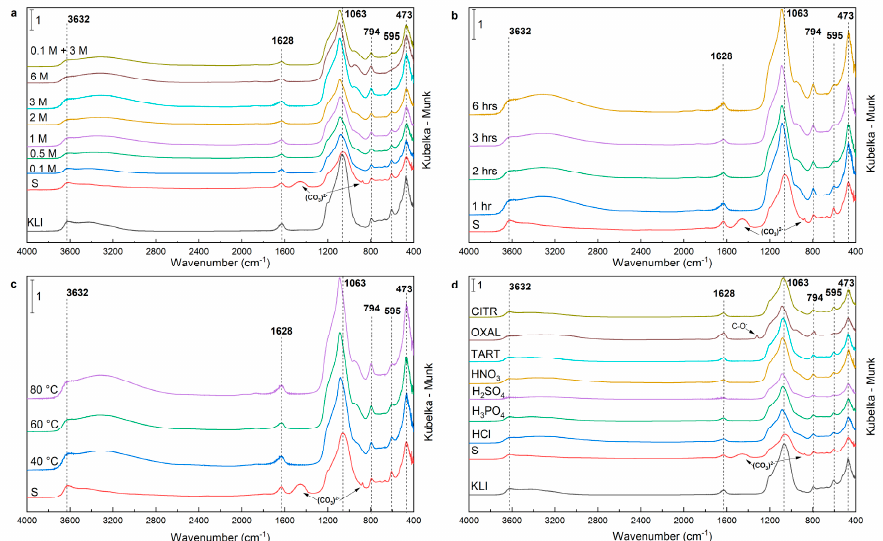
Figure 3. DRIFT spectra of modified foams: Influence of acid concentration ( a ), time ( b ), temperature ( c ), and type of acid ( d